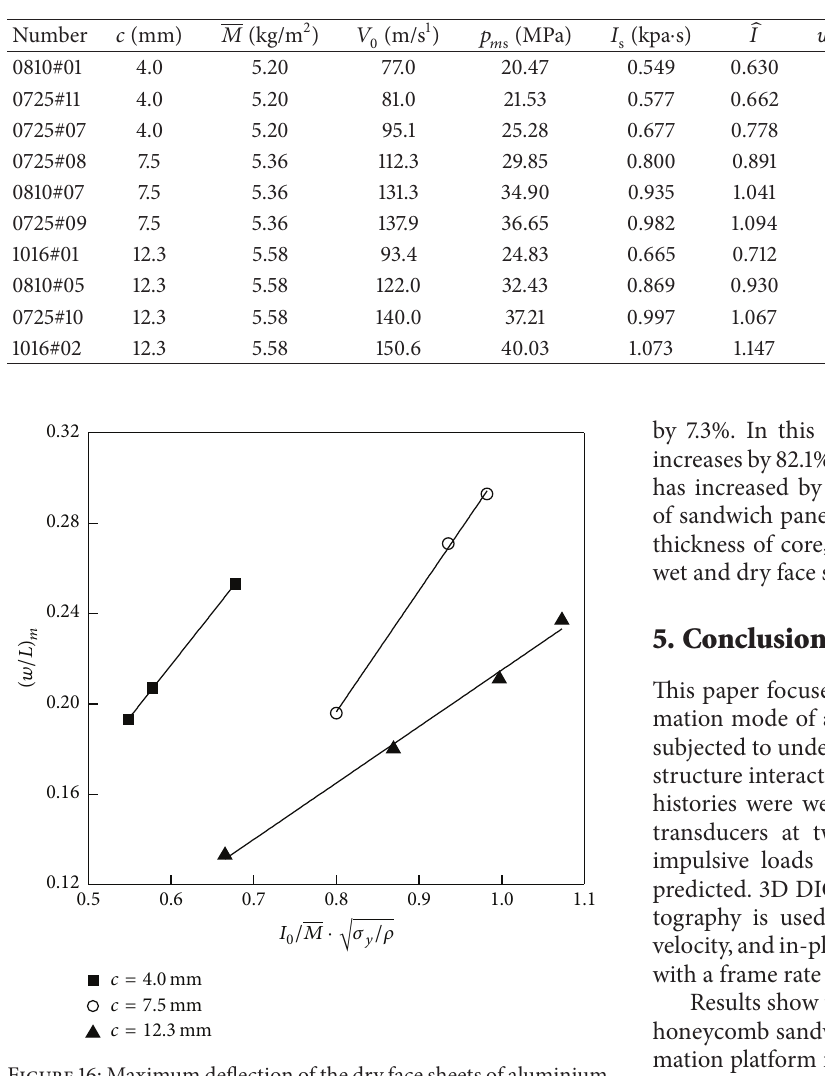
Figure 15: Sandwich panel after impulsive loading: (a) cross section and (b) detail of the wet face sheets near boundary. Table 3: Performance of shock resistance of aluminium sandwich panels.